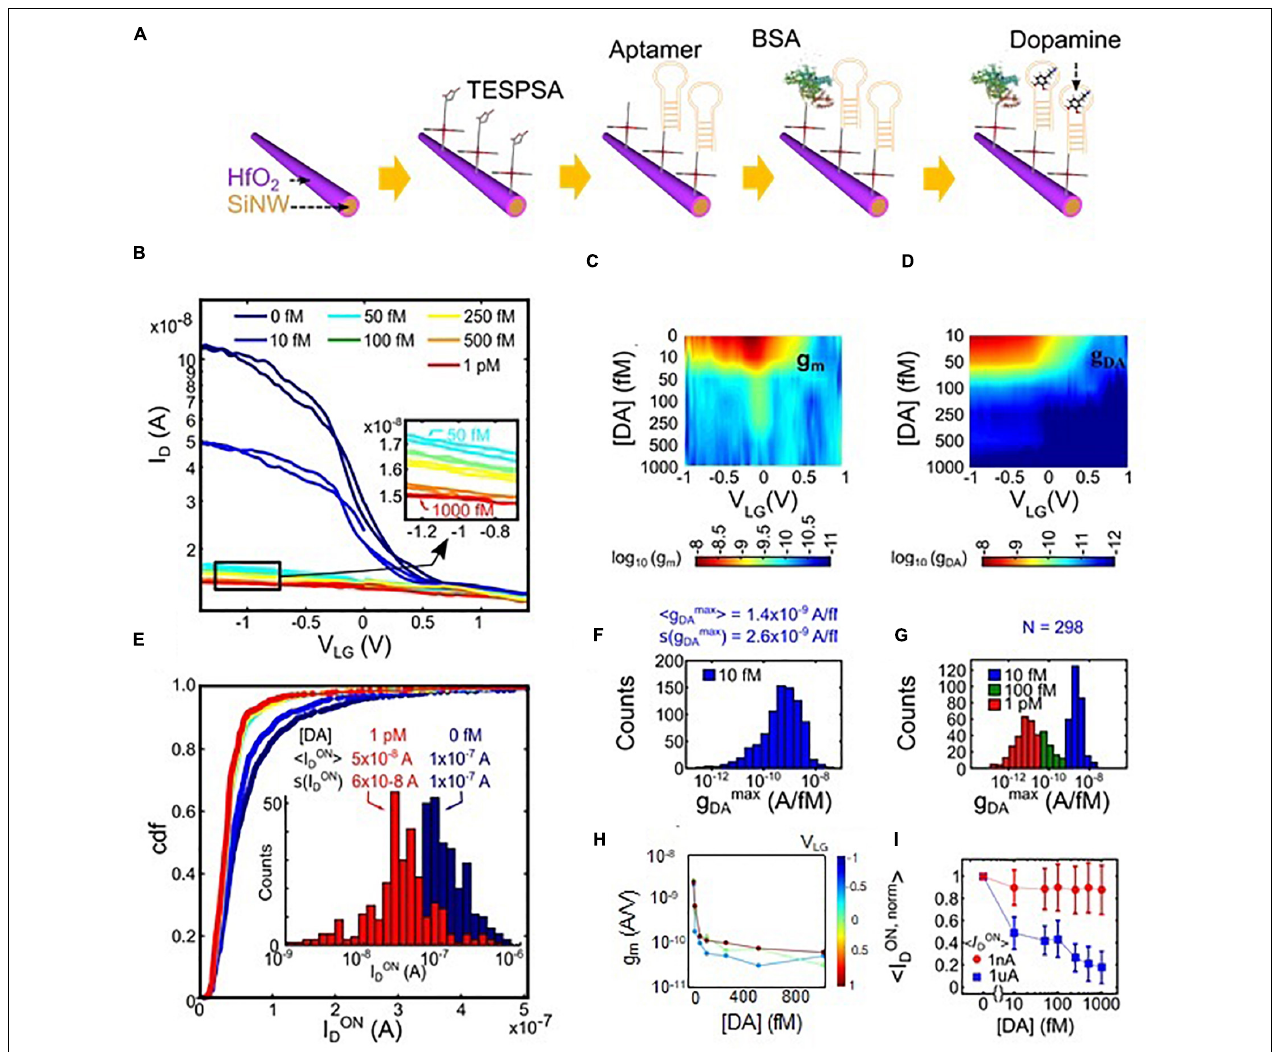
FIGURE 4 | (A) Sequence of functionalization steps of the SiNW surface: bare HfO 2 , silanization, aptamer immobilization and blocking with BSA. (B) Transfer characteristics of a single device upon exposure to different dopamine concentrations [DA]. The applied drain voltage was always V D = 0.2 V. (C) Color plot of g m (nA/V) as a function of the liquid-gate voltage V LG and dopamine concentration [DA]. (D) Color plot of g DA as a function of V LG and [DA]. (E) cdf of I D in the “ON” state for several DA values. Inset shows the histogram of I D comparing the ‘ON’ states at [DA] = 0 fM and [DA] = 1 pM. The measurements were performed at V LG = − 0.8 V. (F) Histogram of the maximum g DA value extrapolated for single devices at [DA] = 10 fM and for the corresponding V LG . (G) Histograms of the maximum g DA for three [DA] concentration values of a selection of devices for which g DA ([DA] = 10 fM) > 10 - 9 A/fM, showing that the highest sensitivity was found in the fM range. (H) g m versus [DA] at three different V LG (high, medium and low) for the same selection of devices as in panel (C) , showing that the maximum sensitivity was found in the transistor ‘ON’ region. (I) Plot of the average normalized ON drain current ID ON , norm measured at V LG = − 1 V, versus [DA]. The average was determined from two SiNW sensor subsets featuring lower (red circles, ID ON approx. 1 nA, subset of 90 SiNW sensors) or higher ID ON (blue squares, ID ON approx. 1 µ A, subset of 7 SiNW sensors). For the second subset, the dynamic range is extended up to 1